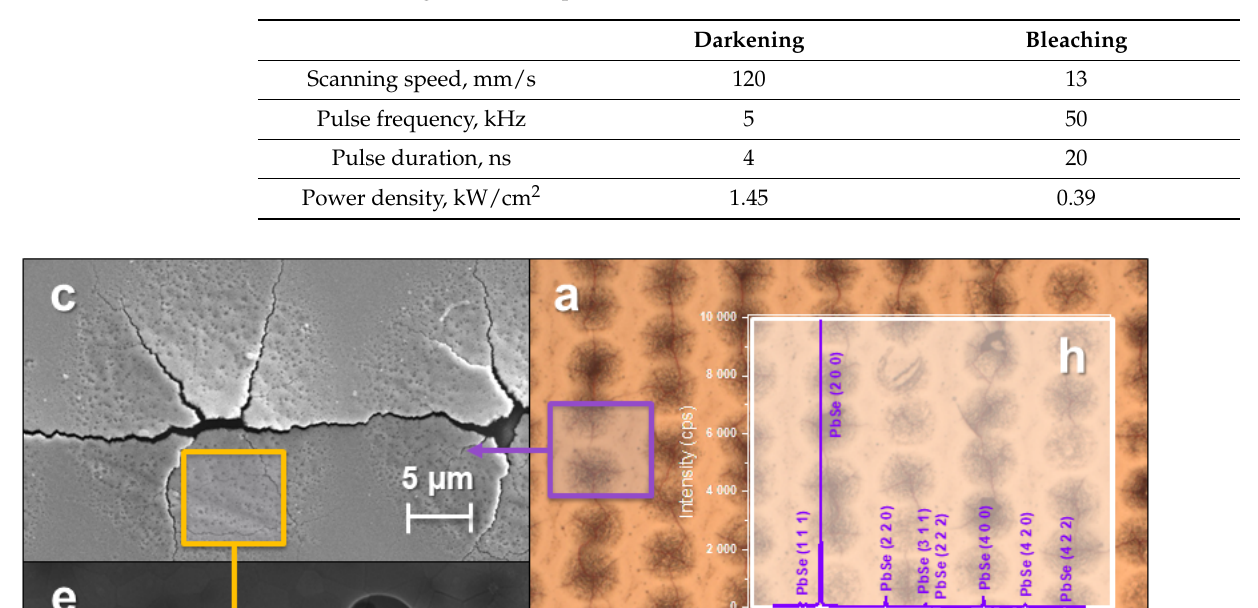
Table 2. Scanning modes with pulsed NIR radiation.